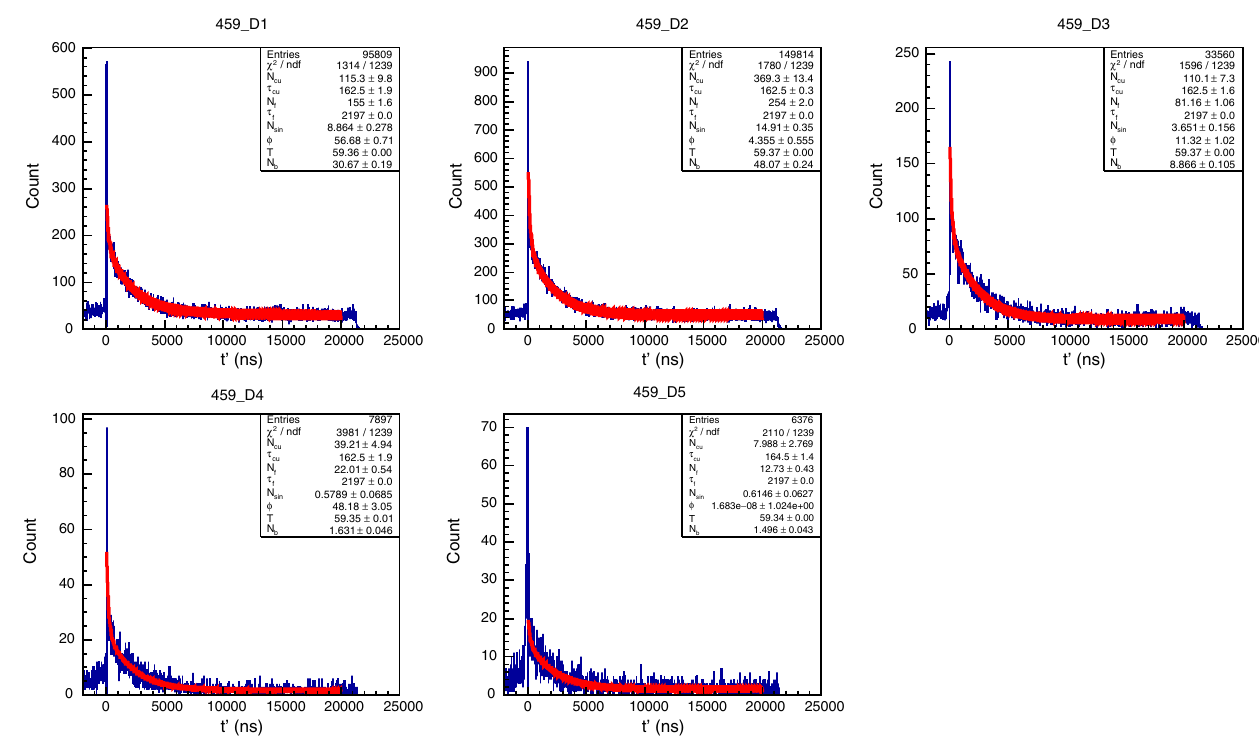
FIG. 3. Time distribution for an example data sample, with a degrader thickness of 5 mm, for each of the five S2 channels. The fit to the data with the function in Eq. (7) and the parameters extracted for each distribution are also